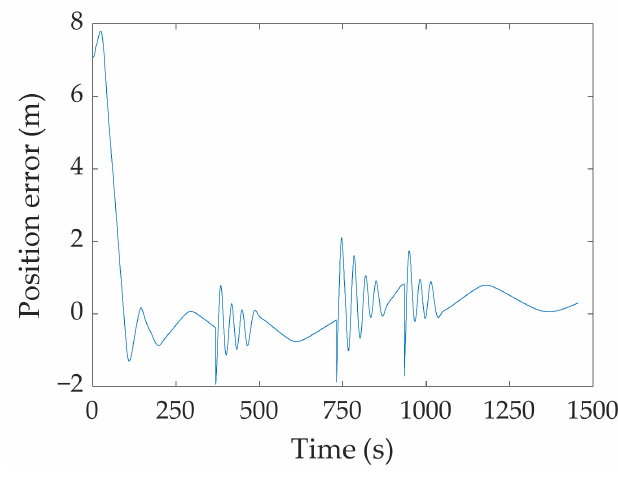
Figure 15. Position error for the rectangular path